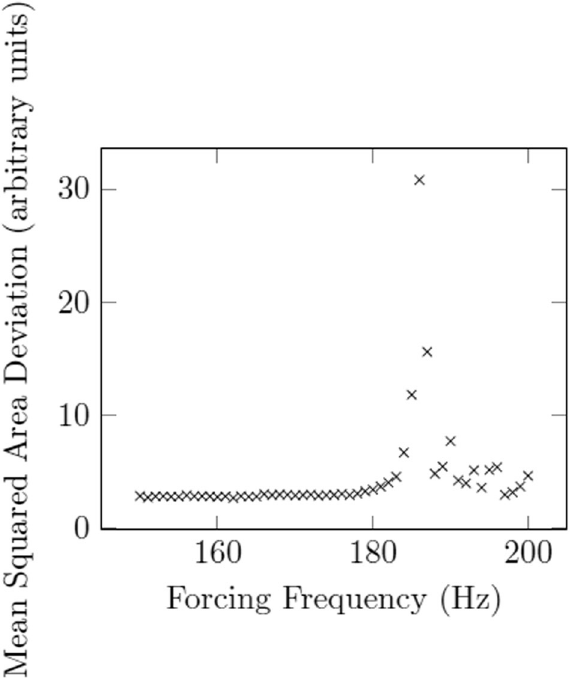
Fig. 5 Resonance curve of Rhodium (45 mg) oscillating in mode n = 2, obtained using an area array at Japan Aerospace Explora- tion Agency (JAXA). The mean squared area deviation of the droplet ’ s shadow over time corresponds to the magnitude of resonance. The resonant frequency is the frequency corresponding to the maximum of this curve.